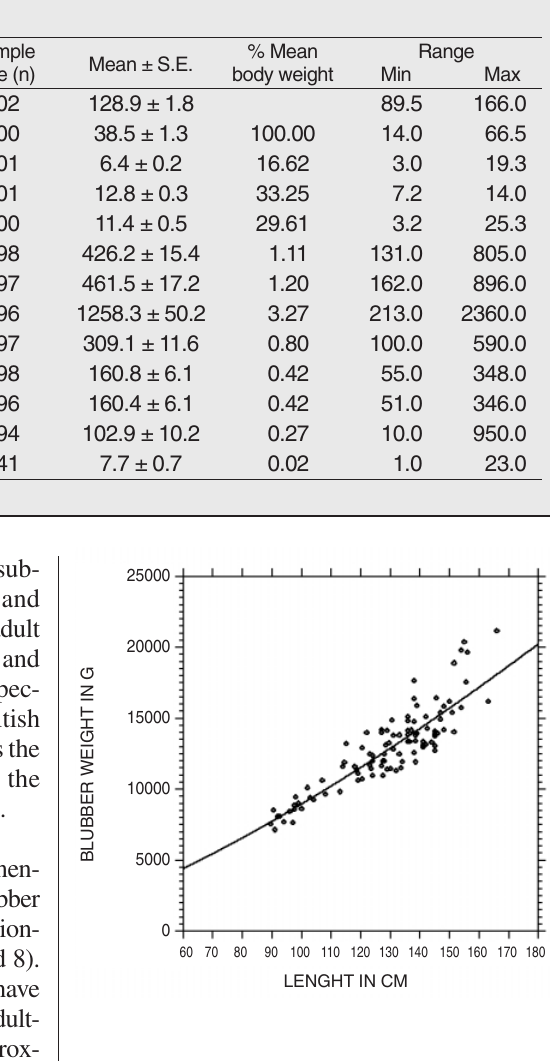
Table 4. Organ and tissue weights expressed as mean ± S.E., percentage of body weight and actual range.